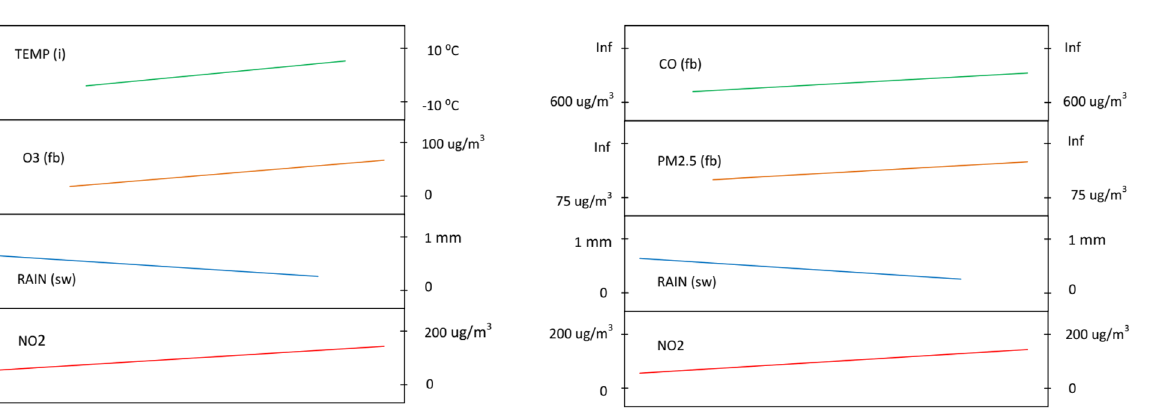
Fig. 5 One of the frequent proto-patterns registered in